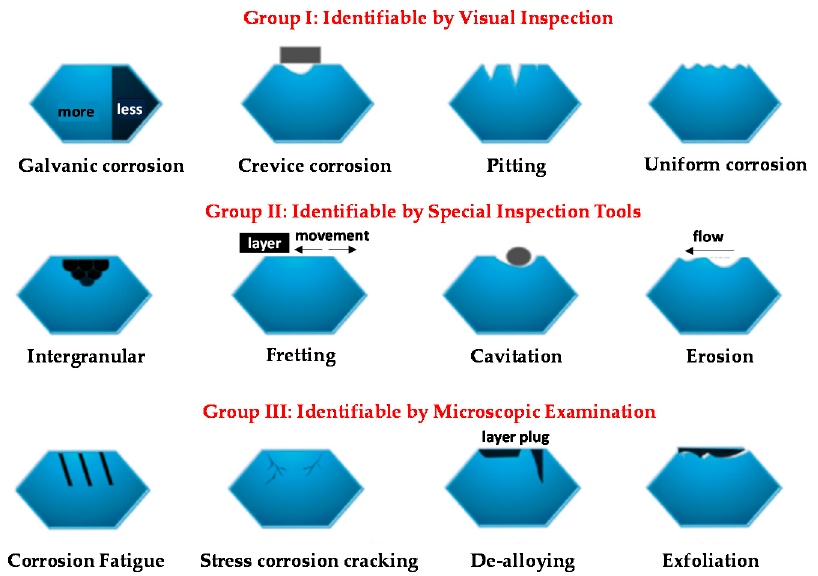
Figure 7. Corrosion forms in titanium-based dental implants are classified into three groups ac- cording to the necessary identification technique. Adapted under the Creative Commons Attribu- tion License from